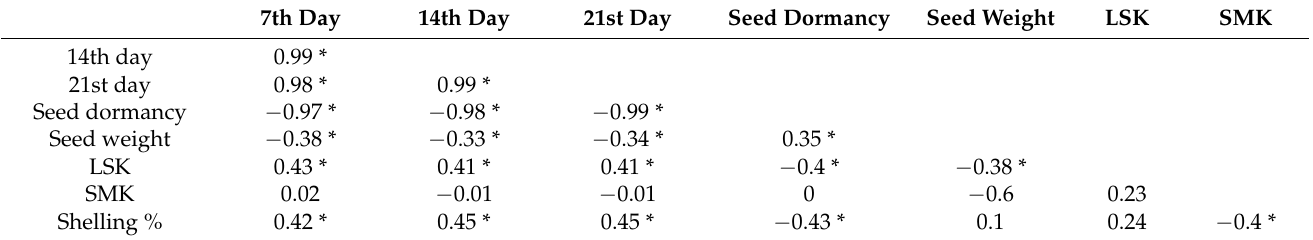
Table 1. Estimating correlations between seed trait using Pearson Correlation Coefficient.